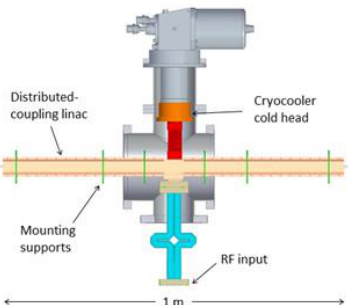
Figure 17. Schematic of the cryogenic X-band linac for VHEE under development at